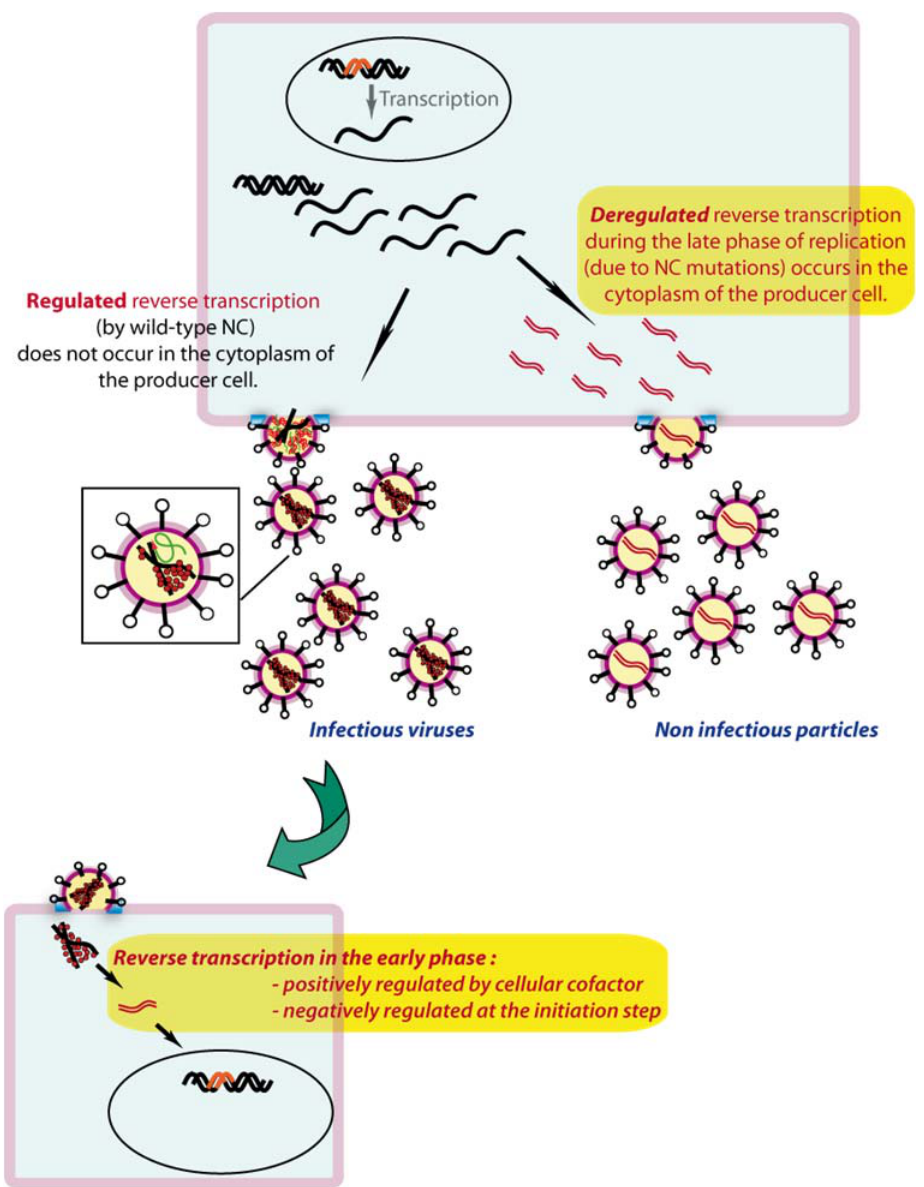
Figure 6. Schematic representation of the temporal regulation of reverse transcription in producer and target